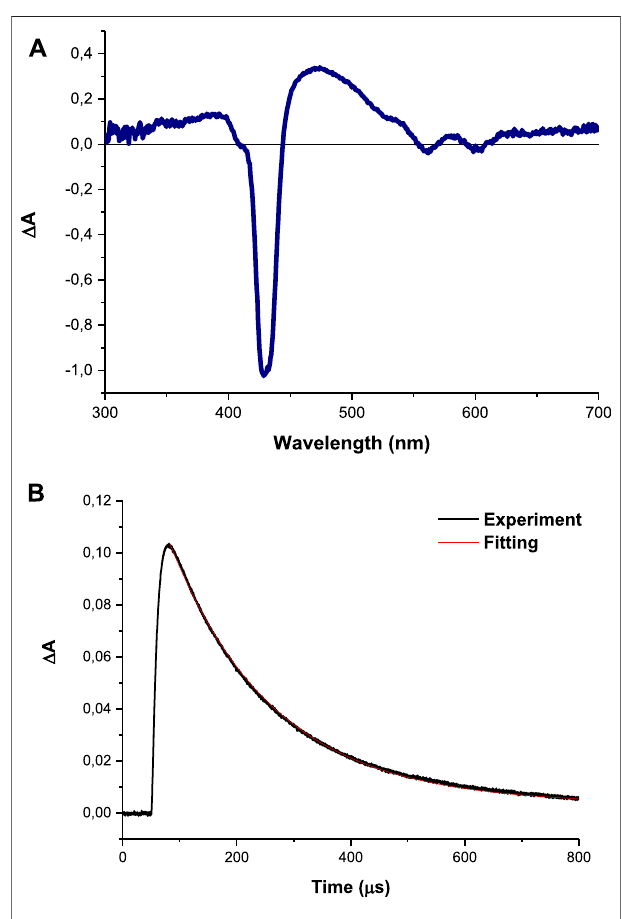
FIGURE 7 | (A) Absorption spectra obtained with LFP at 1 μ s after excitation and (B) transient decay curve (using complex 4 as an example) observed at 425 nm in